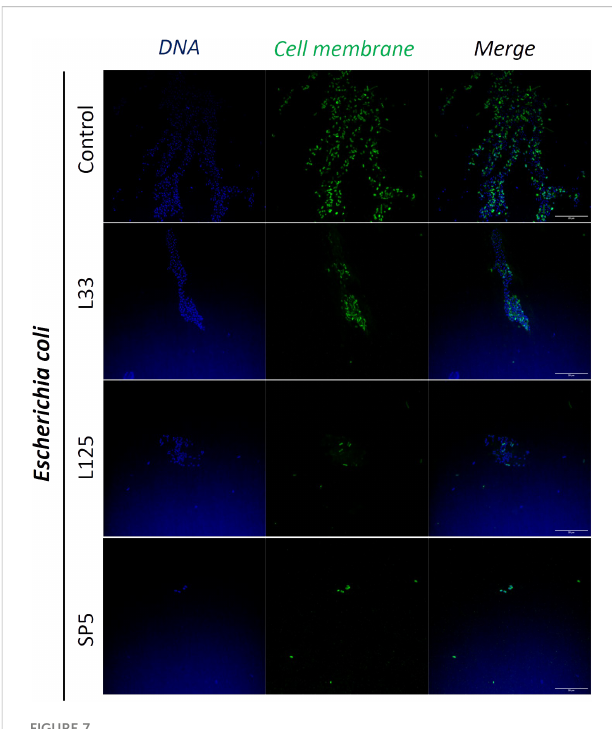
FIGURE 7 Representative images of E. coli cells organized in bio fi lms, after 24 h incubation in TSB (control) or adjusted CFCS (50% v/v, pH 6.2) derived from Lp. pentosus L33, Lp. plantarum L125 or Lc. paracasei SP5. Pathogen cell membranes were stained with CFSE (green) and DNA with Hoechst 33342 (blue) (scale bar, 20 m